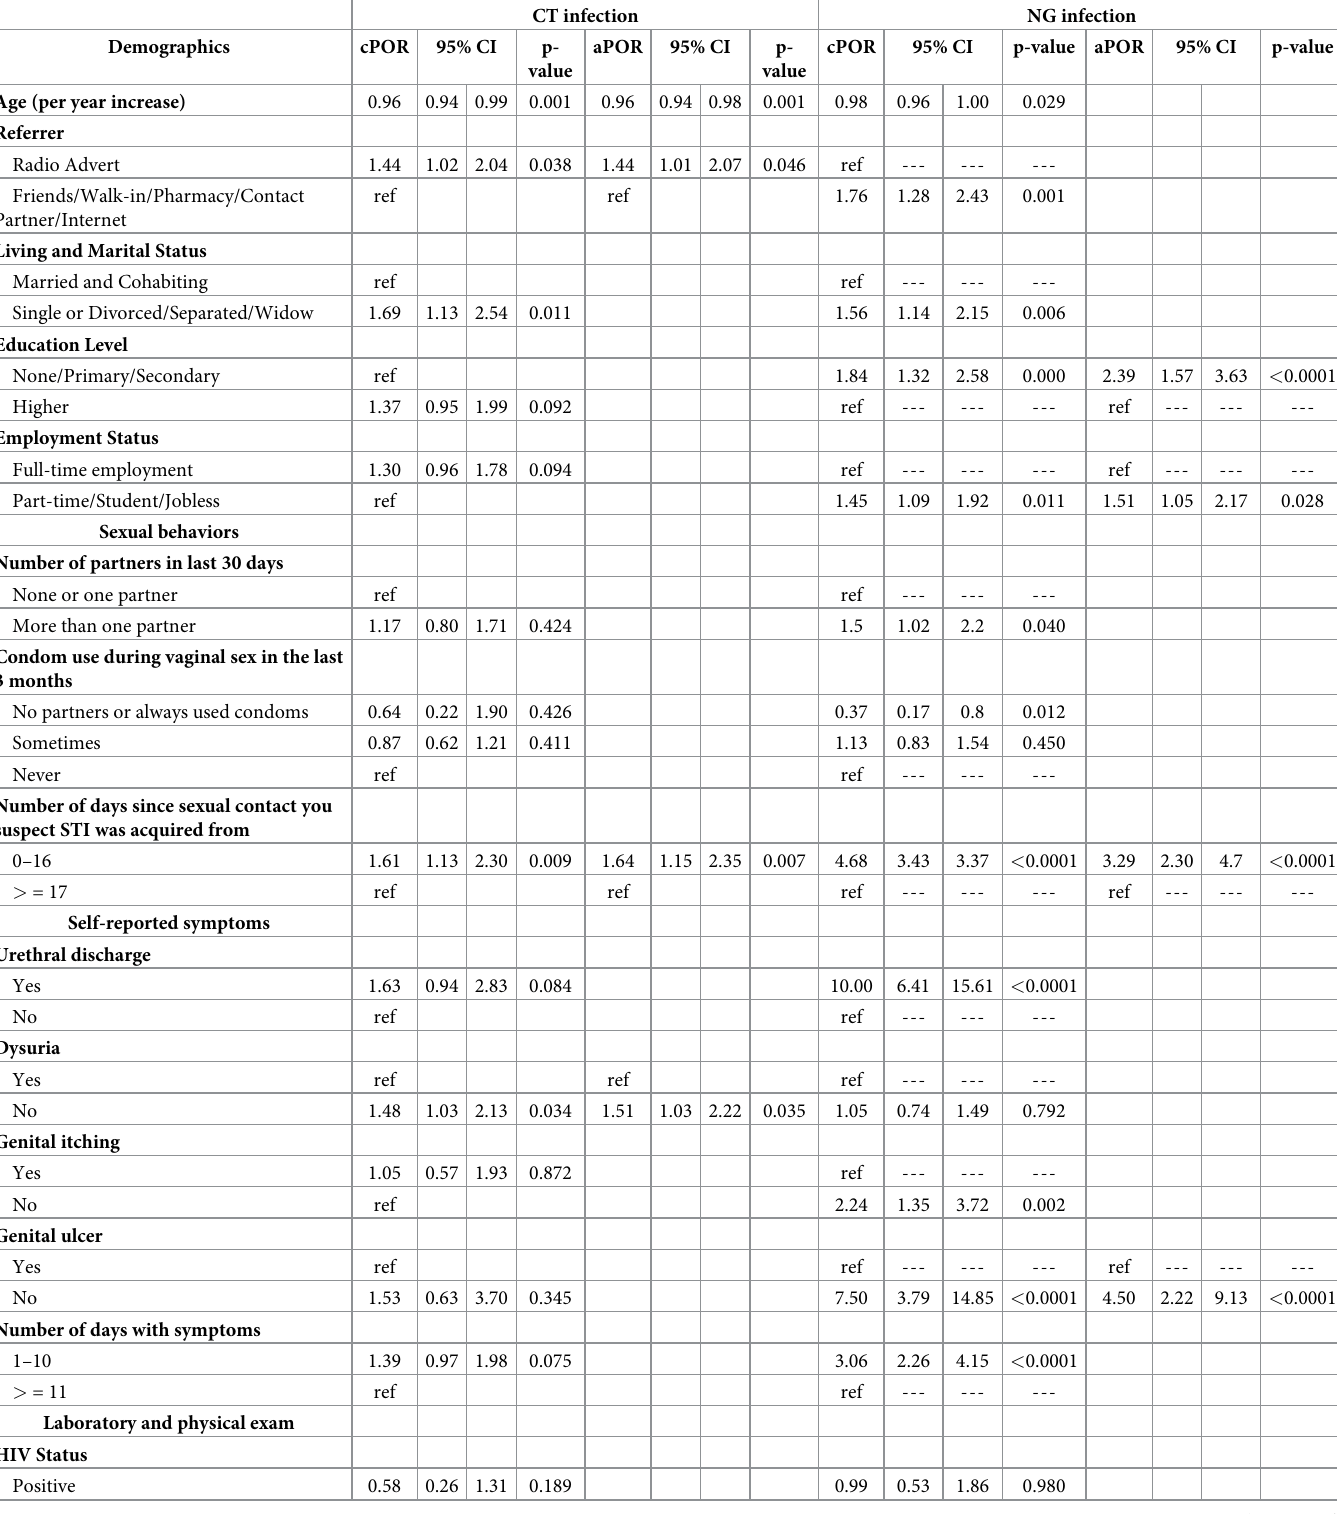
Table 3. Univariate and multivariate analysis of factors associated with CT or NG infection in men in Kigali, Rwanda (N = 1013). CT